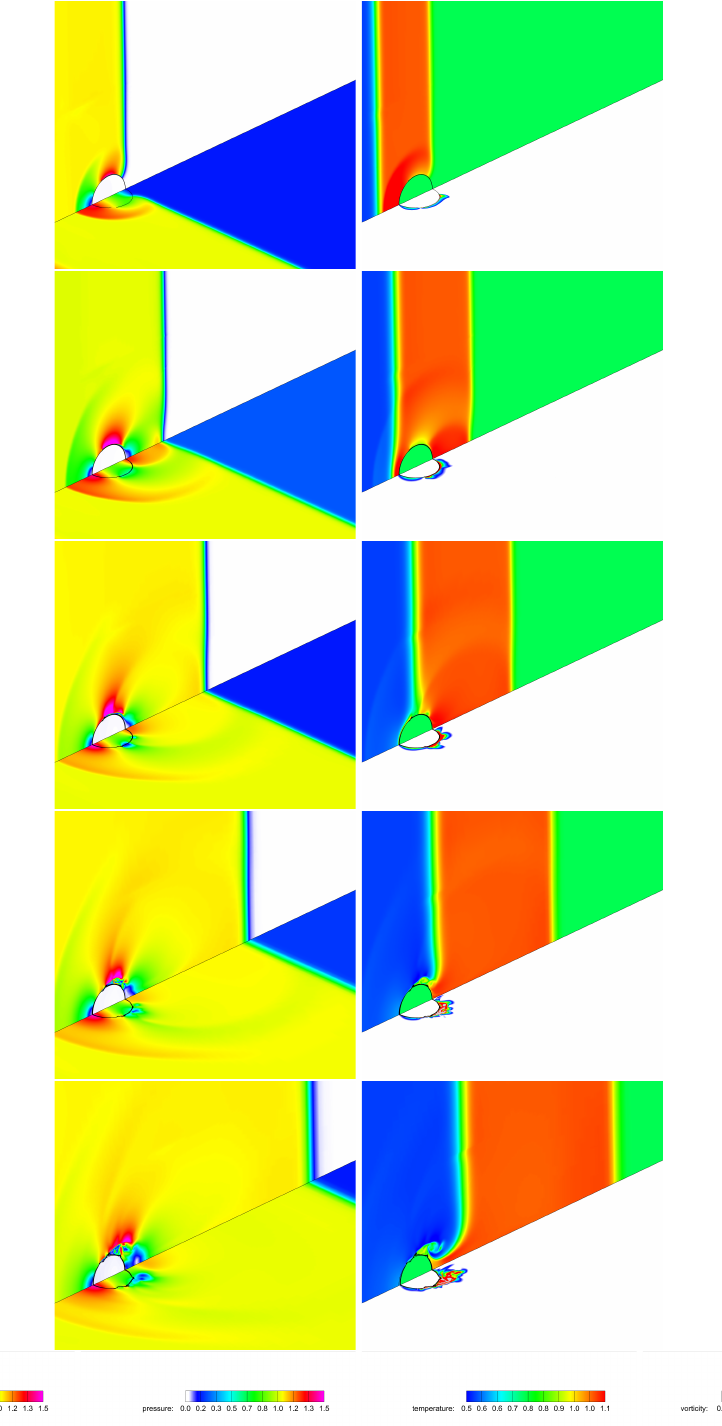
Figure 4. Instantaneous contours for normalized mean flow variables at the midplane x = 0, corresponding to t ∗ = 0.010, 0.044, 0.060, 0.099 and 0.17 (from top to bottom). Vertical planes show speed (left) and temperature (right), while horizontal planes show pressure (left) and vorticity magnitude (right). Main flow is from bottom left to top right